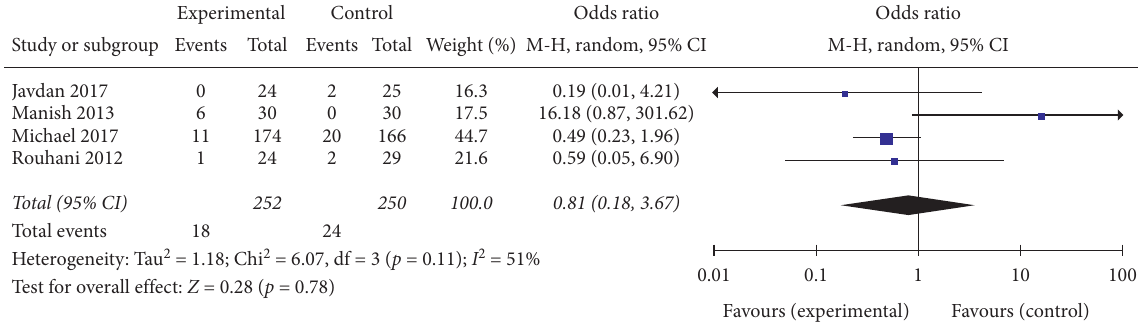
Figure 7: Rate of